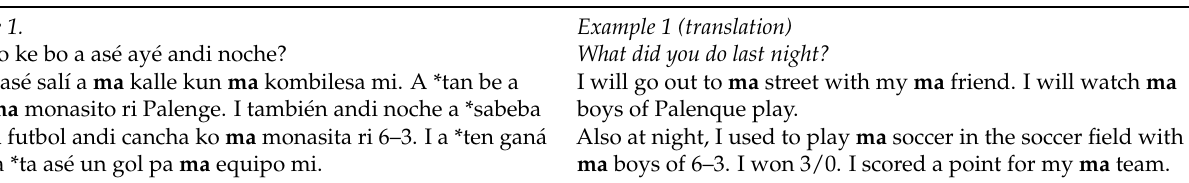
Table 3. Sample analysis of the open-ended question.